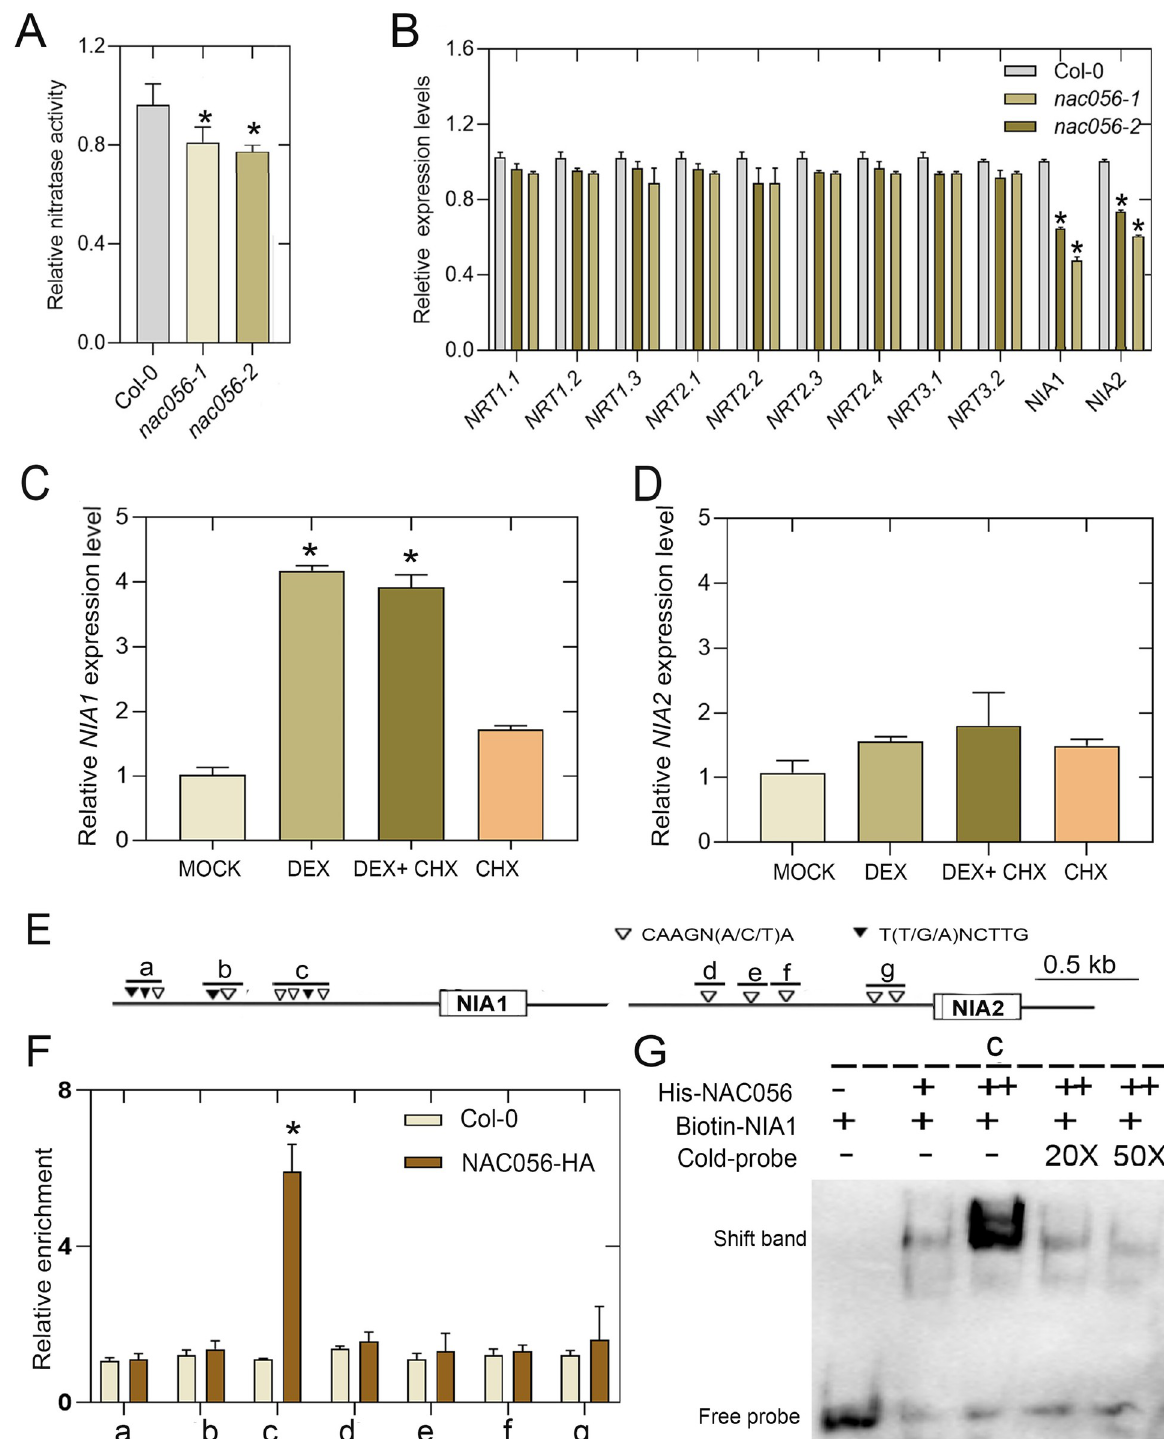
Fig 7. NAC056 regulates genes involved in NO3 − assimilation. A. Measurement of relative nitrate reductase activity in the roots of 11-day-old wild-type and nac056 mutant seedlings. Values are given as mean ± standard deviation (SD), n = 3. � p < 0.05 by Student’s t test, in comparison with Col-0. B. RT-qPCR analysis of nitrate transport- and assimilation-related genes in Col-0 and nac056 mutant plant roots. Values are given as mean ± SD, n = 3. � p < 0.05 by Student’s t- test, in comparison with Col-0. Relative expression level of (C) NIA1 and (D) NIA2 in